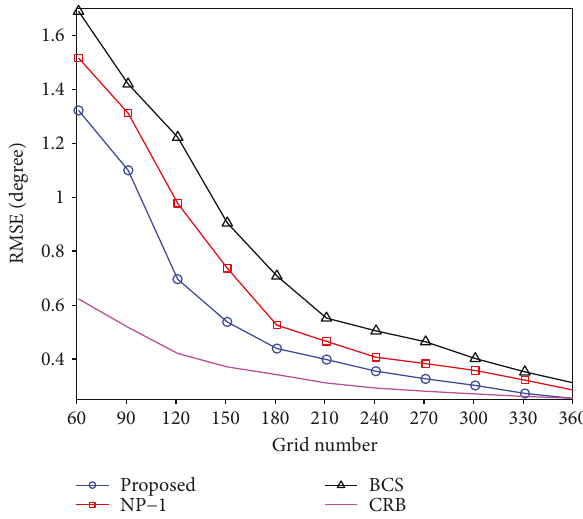
Figure 6: RMSE versus number of snapshots with the fi xed SNR 0dB.